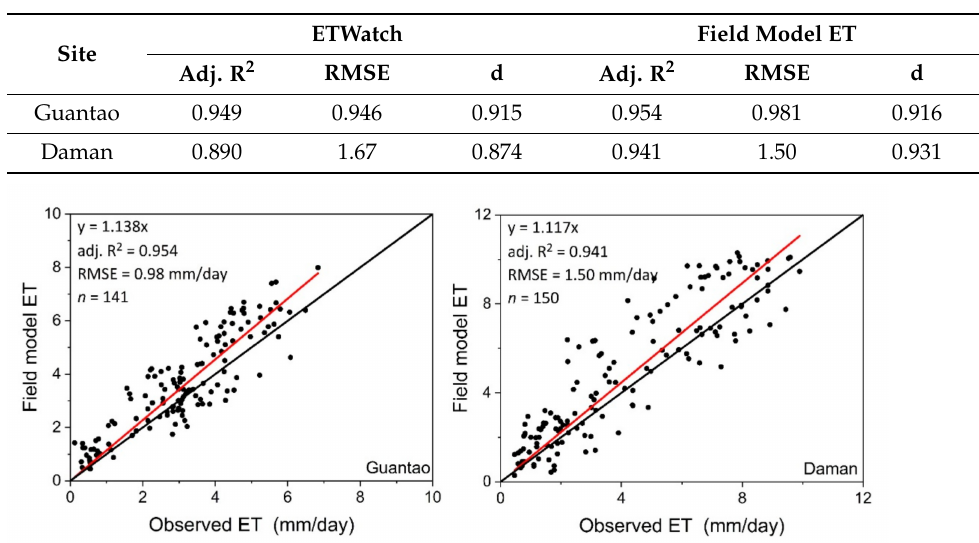
Figure 5. Model validation of the field model ET with the site observations. R 2 : correlation coefficient and RMSE: root mean square error.